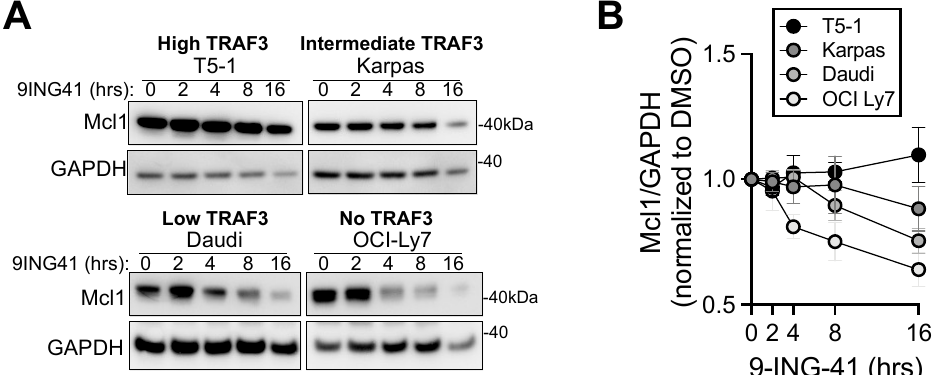
Figure 3. Effect of GSK3 inhibition on Mcl1 degradation in BCL cell lines. ( A ) Representative Western blots of Mcl1 over time of 9-ING-41 treatment in the indicated BCL cell lines. ( B ) Mcl1 and GAPDH were quantified by densitometry and the ratio relative to DMSO treated cells is graphed. Blots in ( A ) are representative of 3 independent experiments, whose results are all graphed as mean ± SEM in B. Uncropped blots and densitometry shown in Figure S5.